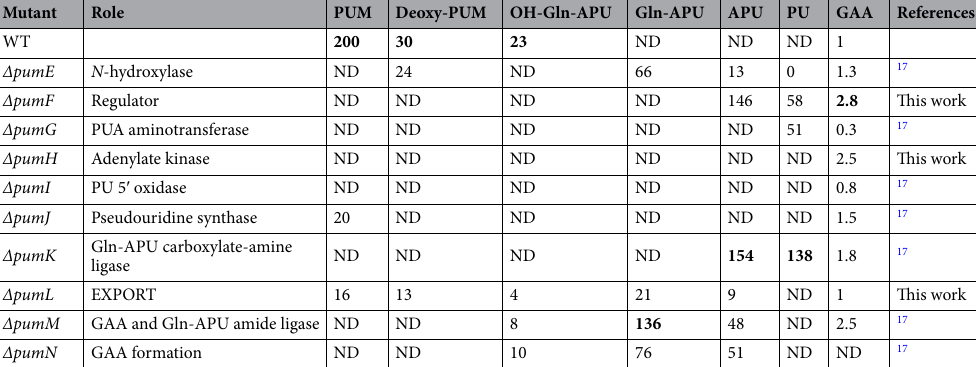
Table 1. pum mutants and accumulated intermediates. Concentrations (µM) of all intermediates except GAA were measured against a PUM standard. GAA concentrations expressed as ratios to the accumulation in the WT strain. The highest production of each metabolite is in bold type. See text for abbreviations. ND not